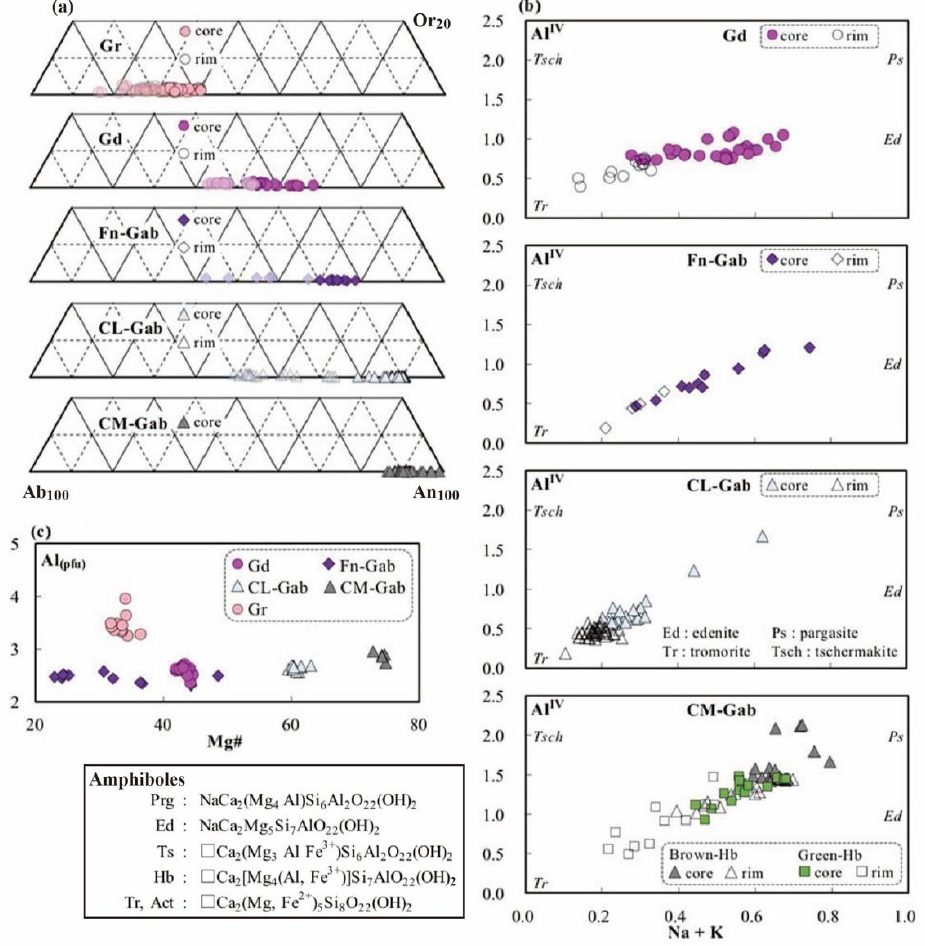
Figure 5. Chemical composition of each mineral. ( a ) plagioclase, ( b ) hornblende, ( c ) biotite. Gd, granodiorite; Gr, granite. See text for a detailed explanation.